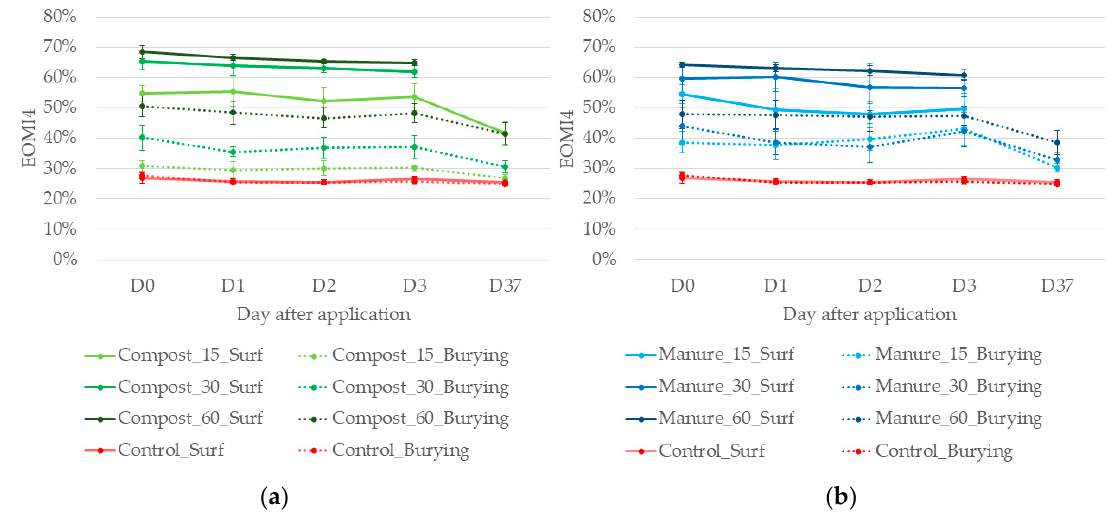
Figure 7. Temporal change of EOMI4 values for all treatments. ( a ) Green waste compost; ( b ) sheep manure treatments. Dashed lines are for the Burying treatments.